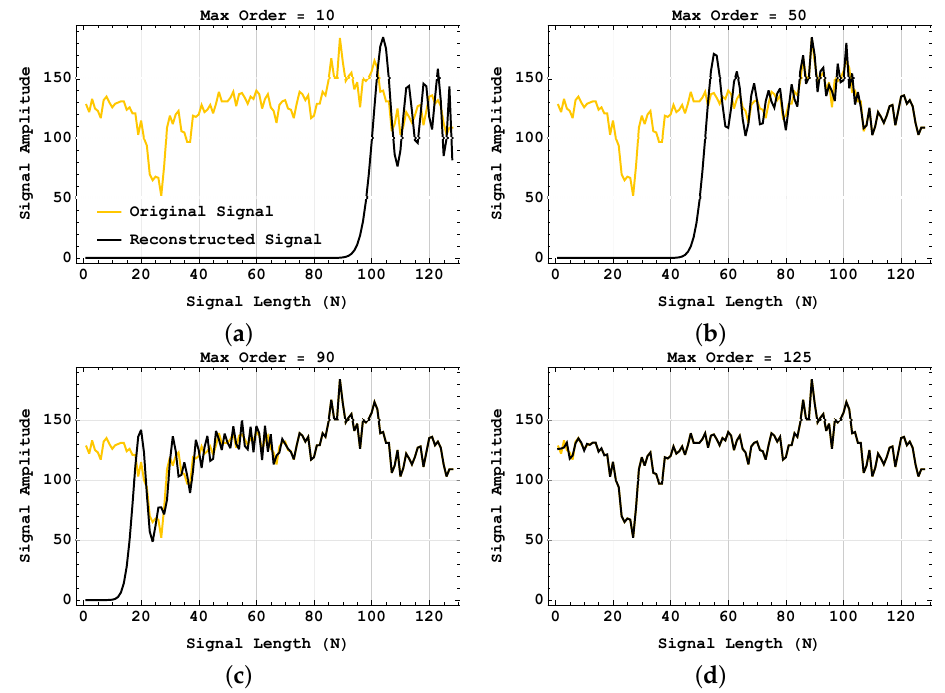
Figure 13. Signal reconstruction of the orange signal in Figure 9d with different maximum orders: ( a ) 10, ( b ) 50, ( c ) 90, and ( d ) 125. p =